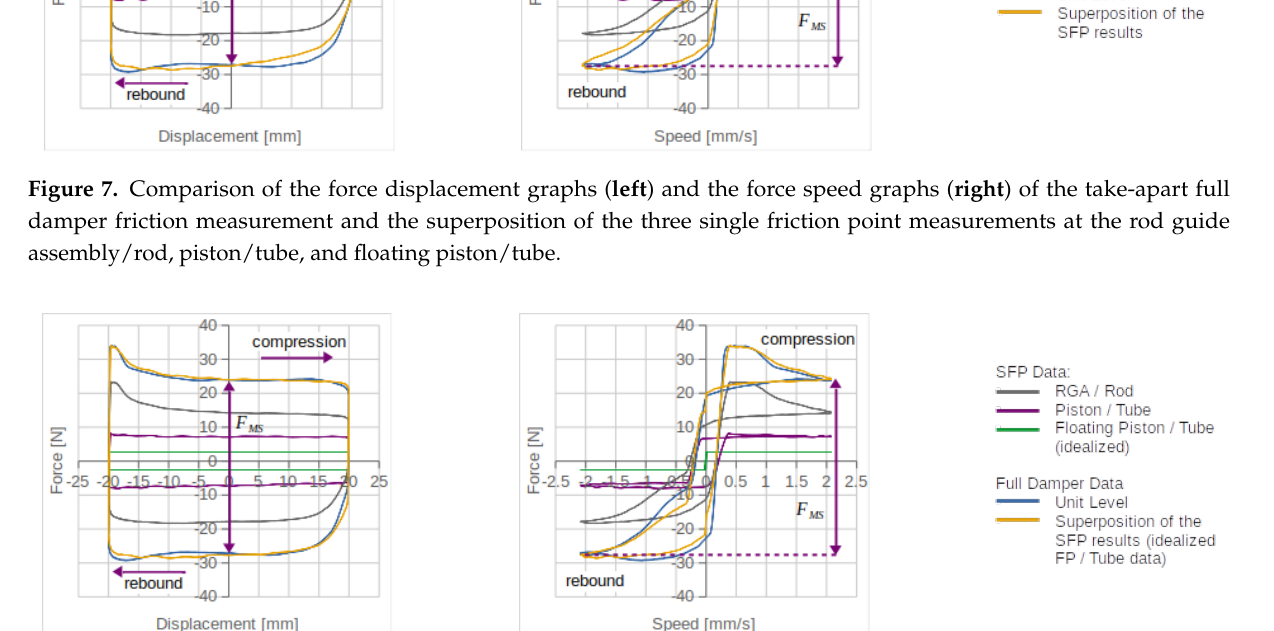
Figure 8. Comparison of the force displacement graphs ( left ) and the force speed graphs ( right ) of the take-apart full damper friction measurement and the superposition of the single friction point measurements of the rod guide assembly/rod and piston/tube, and a fictional idealized floating piston/tube graph.